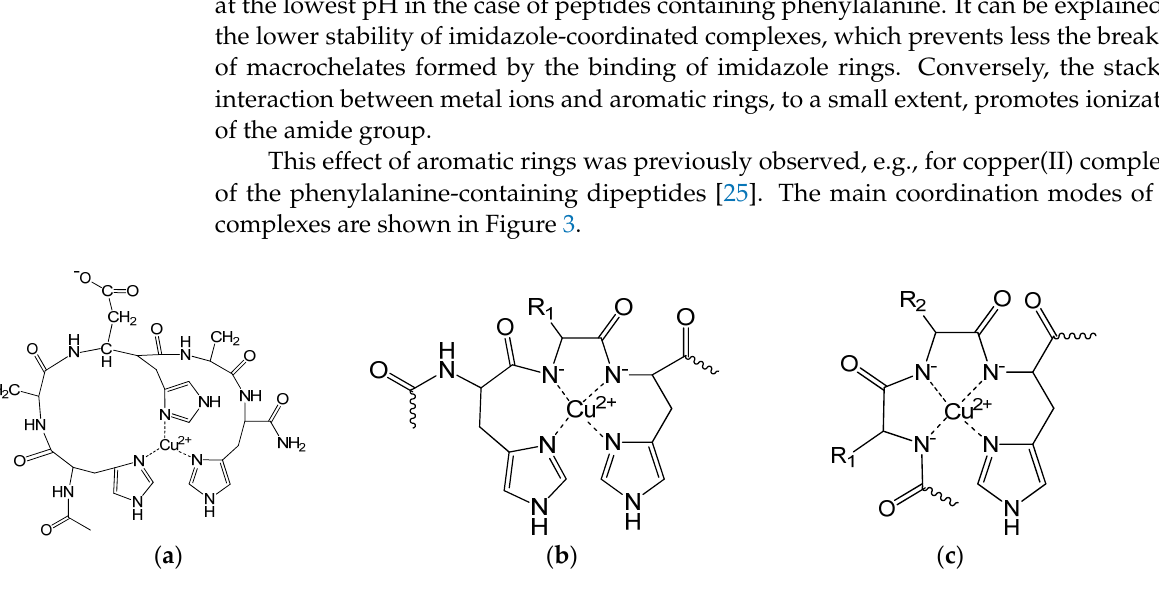
Figure 3. Schematic structure of the main complexes: [CuL], L = Ac-HADHAH-NH 2 ( a ), [CuH − 2 L], L = Ac-(HX) n H-NH 2 ( b ), [CuH − 3 L] ( c